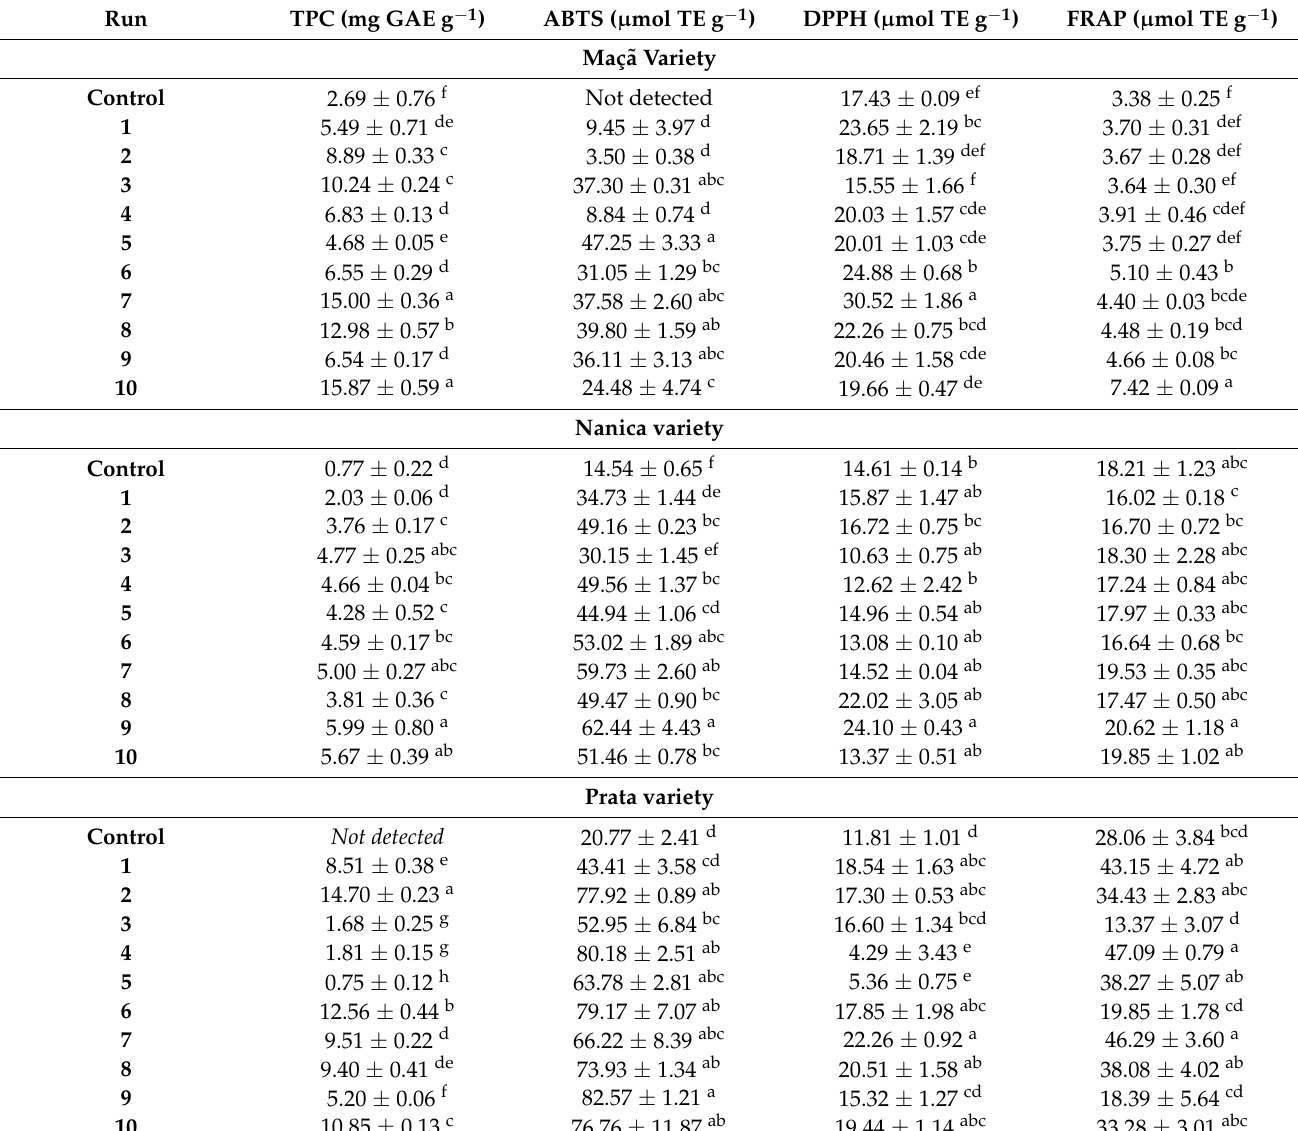
Table 2. Results for total phenolic compounds (TPC) and antioxidant activities (ABTS, DPPH and FRAP assays) in banana bract extracts obtained by use of different enzymes (pectinase, protease and cellulase) and a combination of them.